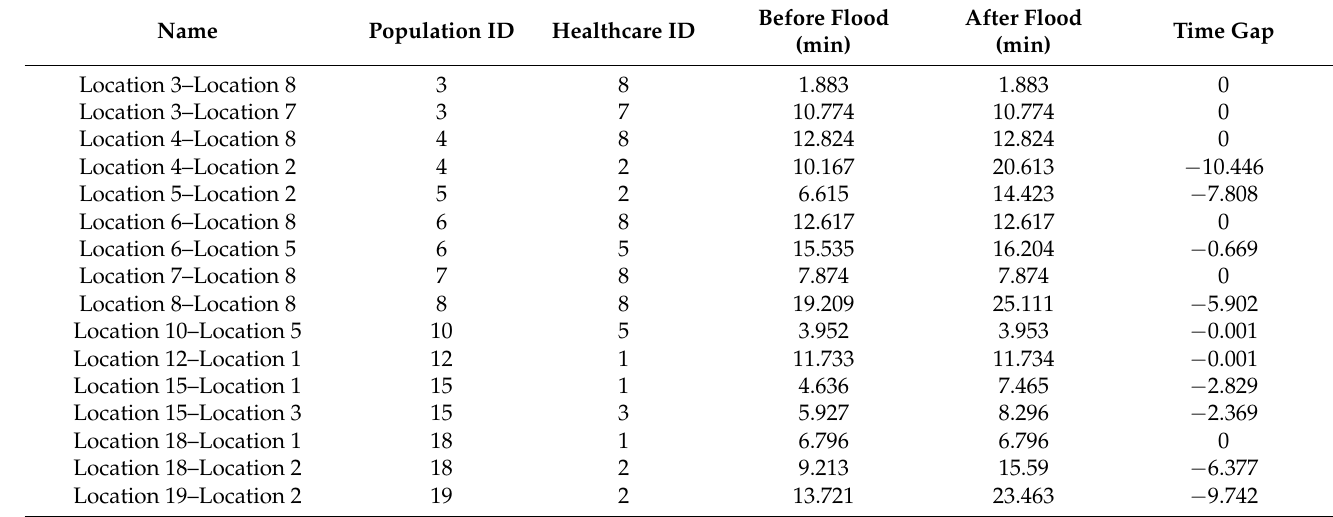
Table 8. Comparison of travel time for the same origins and